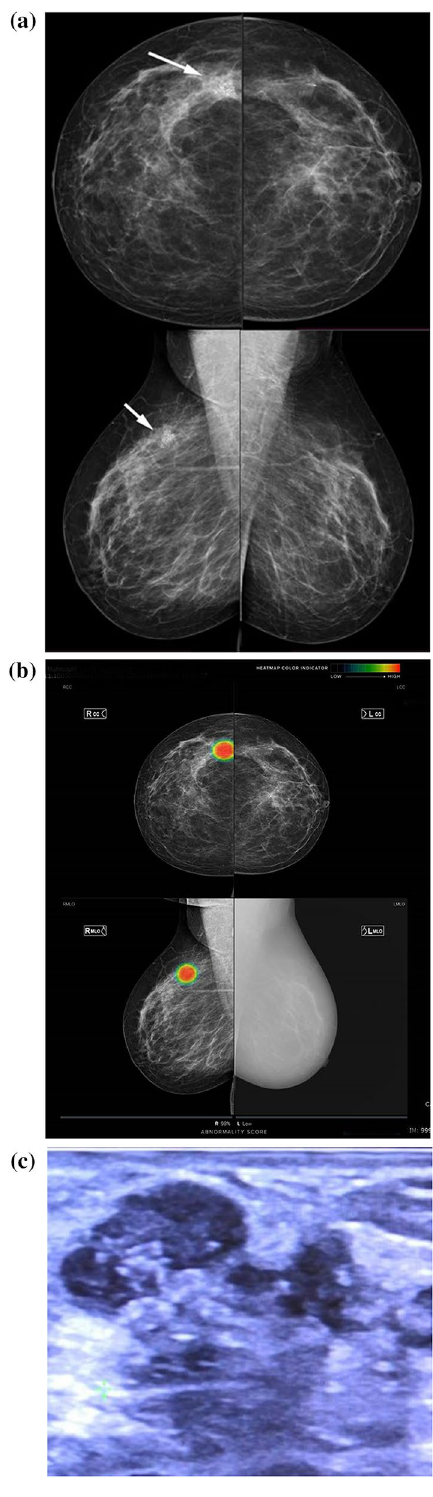
Fig. 3 A fifty-five-year-old lady presented with a mass in the right breast. Mammography showed right upper outer quadrant focal asymmetry with a cluster of microcalcifications seen within as shown in a . The US revealed right breast atv0 o’clock altered parenchyma mounting to mass formation. AI software revealed right breast upper outer quadrant showed an overlaid heat map, high lighting the area of suspicion with PoM scoring 99% indicating a malignant lesion as shown in b . The final diagnosis was right breast